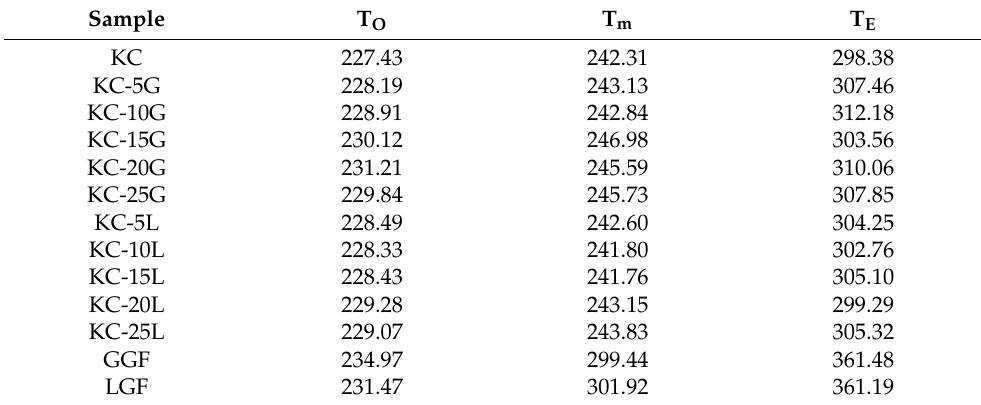
Table 3. Decomposition parameters of KC, KC-G, KC-L, GGF and LGF.